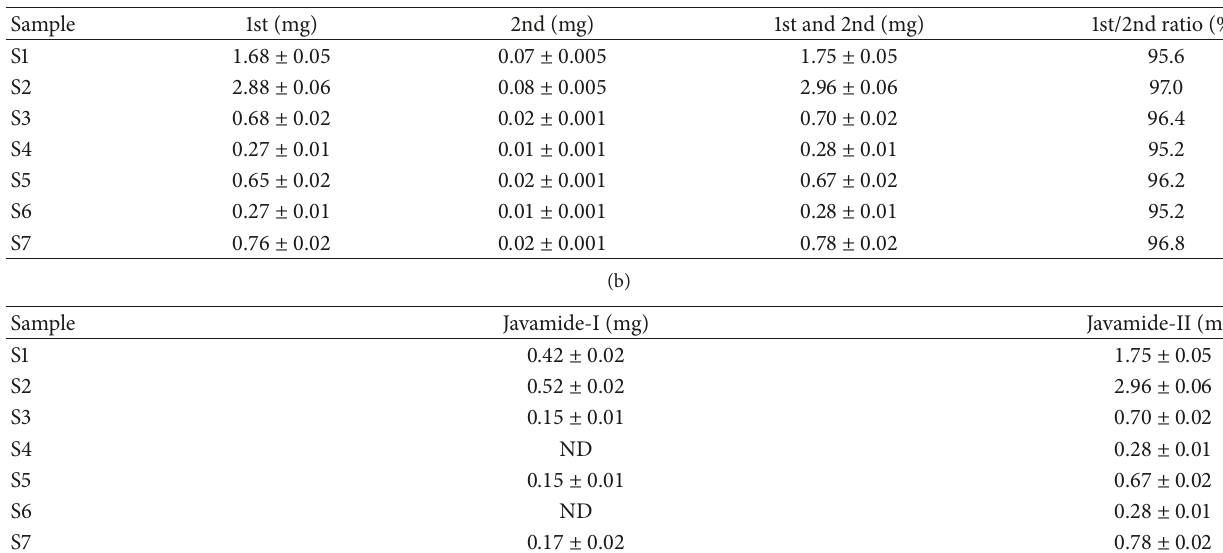
Table 4: (a) The amounts of javamide-II in seven green coffee samples. Seven green coffee extract samples (S1–S7) were individually extracted twice with 70% MeOH extracts (50mL) as described in Table 1, providing the 1st and 2nd extracts. (b) The amounts of javamide-I/ javamide-II in the samples. The amounts were presented as mg per 1g green coffee sample ( 𝑛 = 5